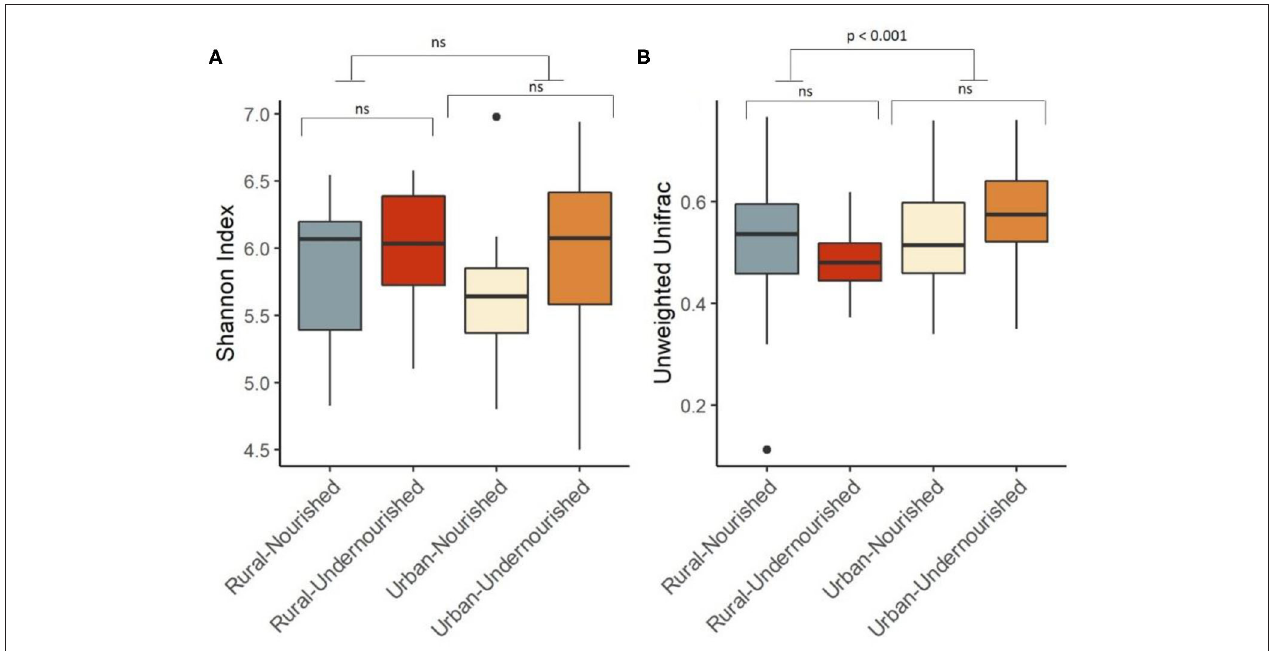
FIGURE 2 | Box and Whisker plot depicting. (A) Shannon Diversity ( α diversity index) in undernourished and nourished from urban and rural settings; (B) Beta Diversity (unweighted Unifrac distances) in undernourished and nourished in urban and rural settings. p -values indicate statistical significance from independent t -tests comparing nourished and undernourished study groups in both the locations (i.e., rural normal vs. rural undernourished and urban normal vs. urban-undernourished) and independent t -test based on location (i.e., rural vs. urban-slum). Box-and-whisker plots show high, low, and median values, with lower and upper edges of each box denoting first and third quartiles, respectively. ns indicates non-significant p -values. Black dots represent the